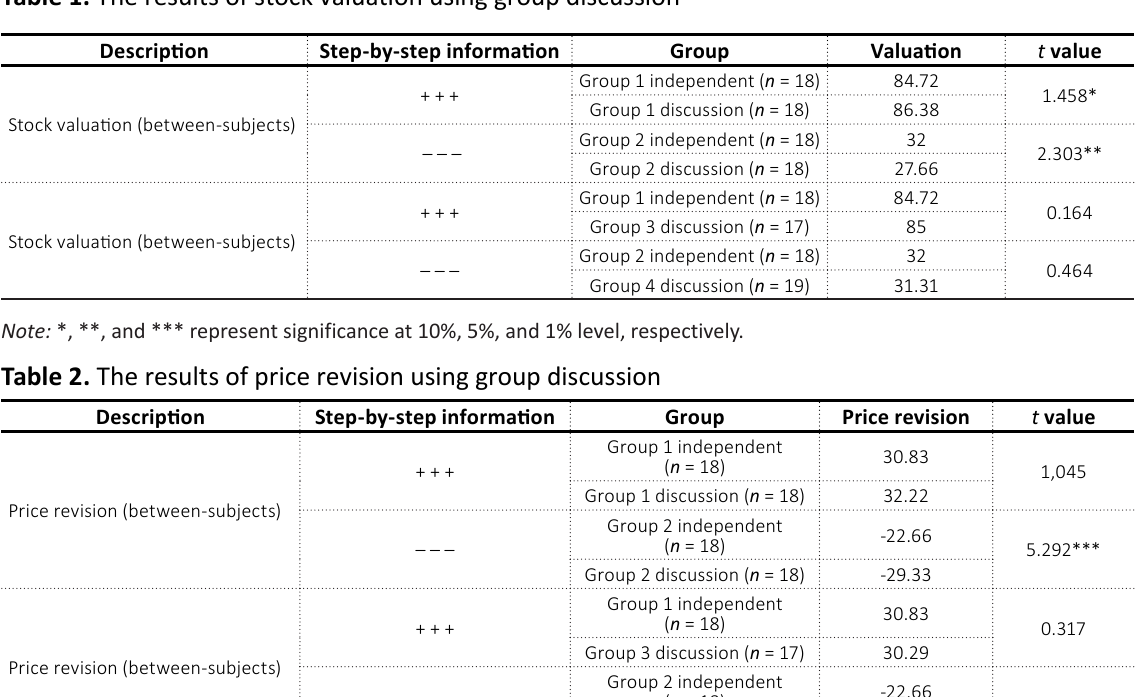
Table 1. The results of stock valuation using group discussion